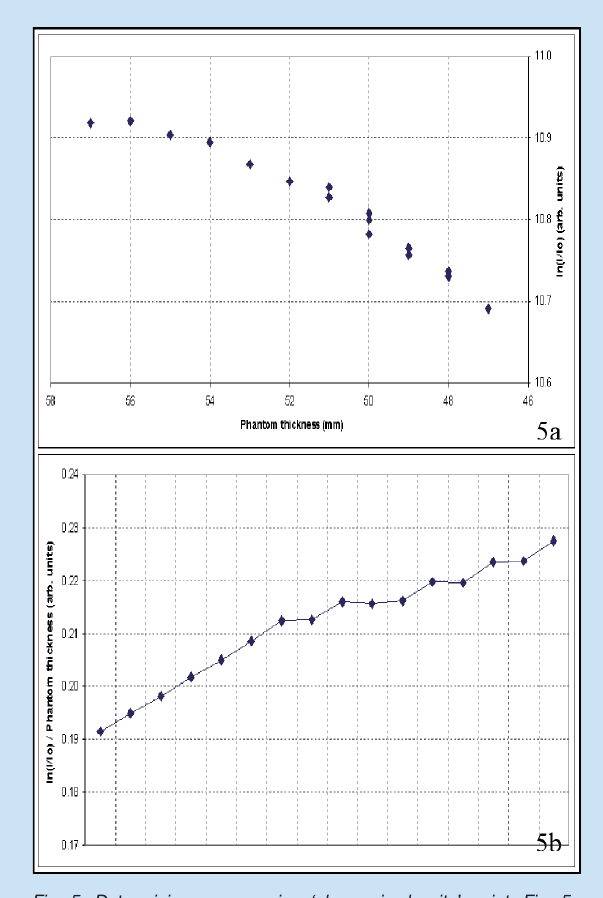
Fig. 5. Determining compression ‘change-in-density’ point. Fig. 5a (above): Phantom thickness versus ln (I/Io) with µ the slope of the graph. Fig. 5b (below): Line graph of